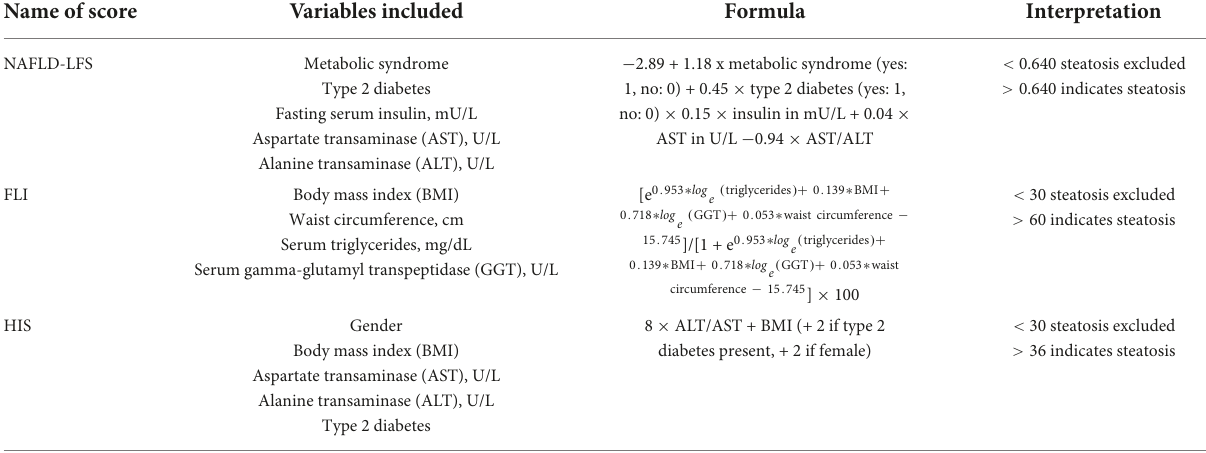
TABLE 1 Biochemical scores that were used for definition of liver steatosis. Name of